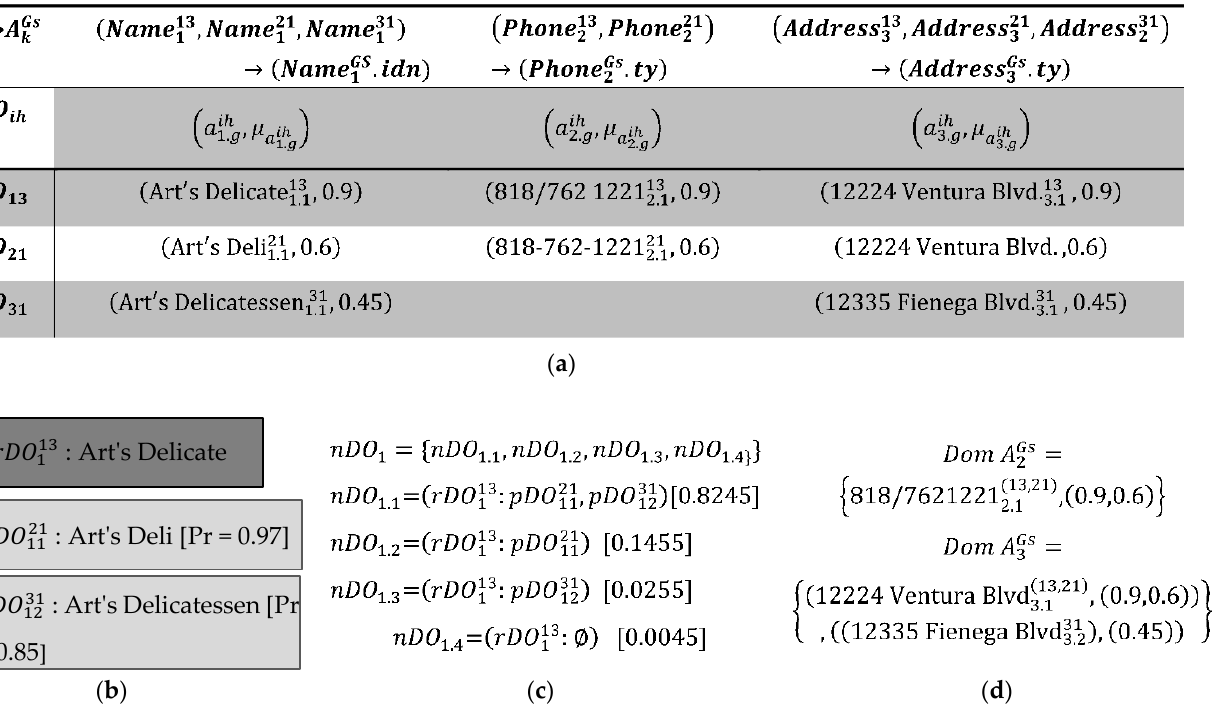
Figure 4. Example of the probabilistic data fusion problem under the existence of multi-valued attributes . ( a ) The participated iDO instances. ( b ) The pair-wise probabilistic Linkages . ( c ) The probabilistic entities merging alternatives from 4b instances . ( d ) The populated data values for the global attributes of the participated instances in 4c.